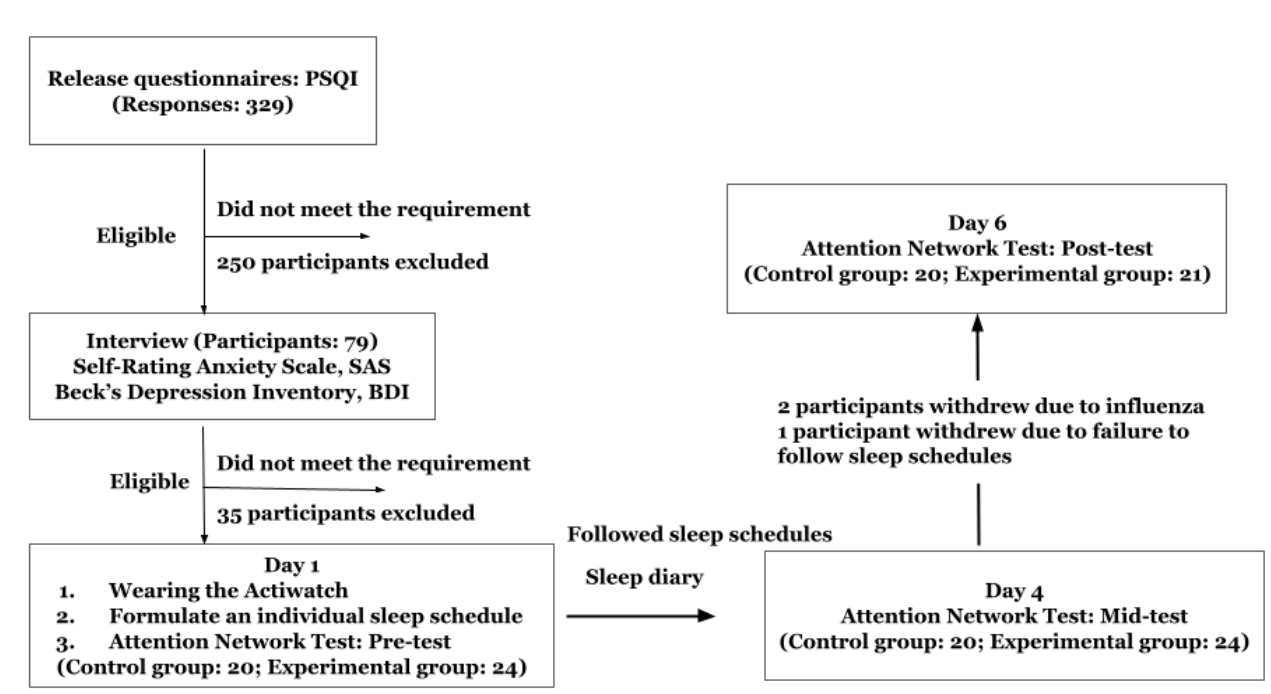
Figure 2. Schematic of the experimental procedure.